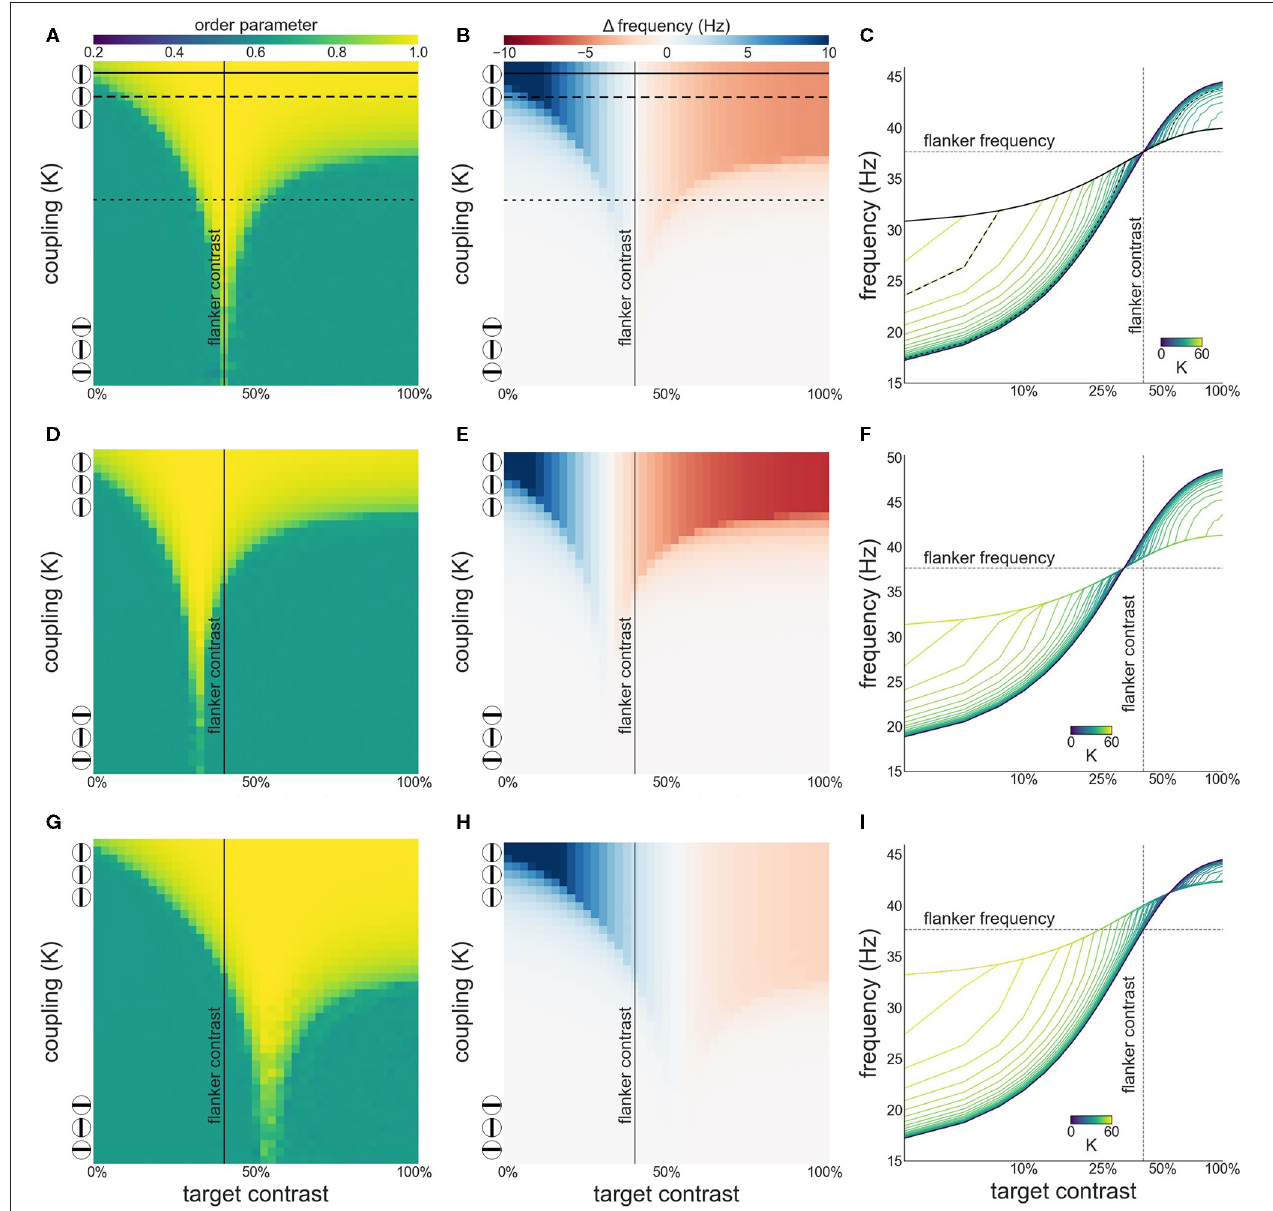
FIGURE 7 | Interactions between target and flanker populations, with flanker contrast is fixed at 40% (vertical line). Formatting of each row is identical to Figure 3 . Results are shown for the simulation without attention (A–C) , with attention on the target (D–F) , and on the flankers (G–I)